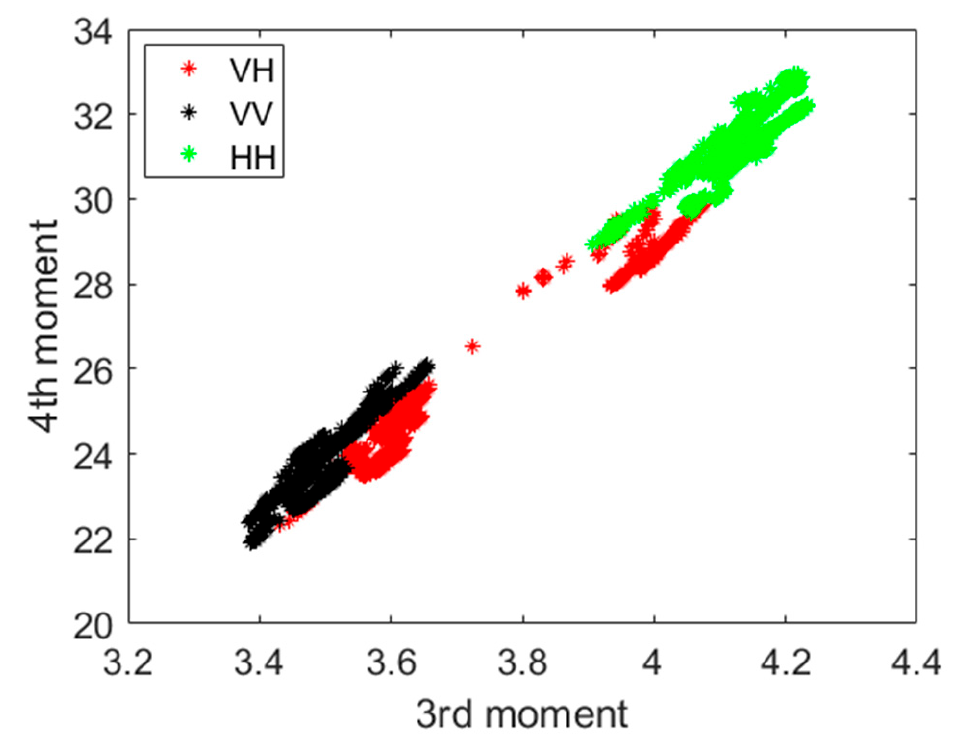
Figure 11. Statistical feature distribution of echo signals in three polarization modes for the pedes- trian.